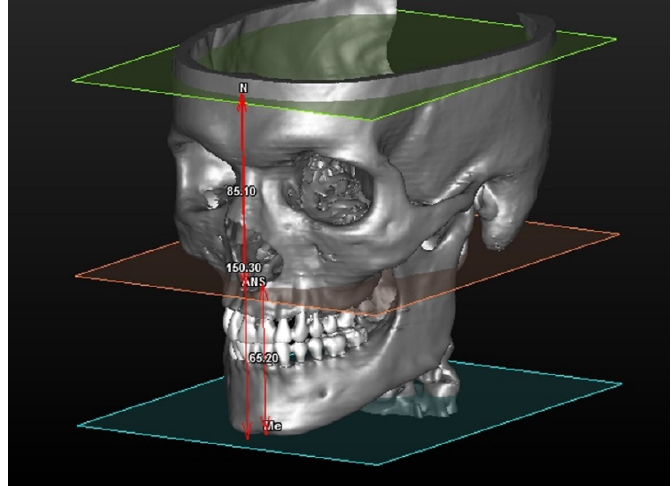
Figure 1. Once planes are drawn, it is possible to measure: (1) Antero-superior vertical dimension (the distance between SFP and anterior nasal spine.), (2) Antero-inferior vertical dimension (the distance between AnSpPl and Mento point) and (3) Anterior total vertical dimension (the distance between the MePl and Nasion point).